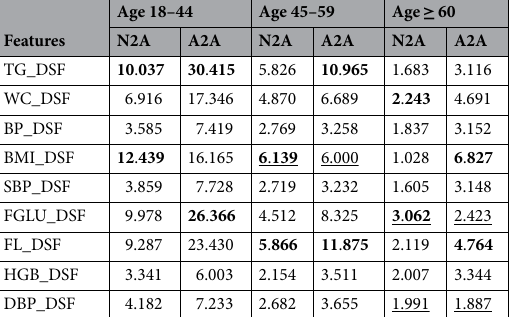
Table 6. The OR of the presistent abnormality (A2A) compared to sudden abnormal state (N2A) in female. The result with the best performance in each metric using different classifiers are marked in bold characters.